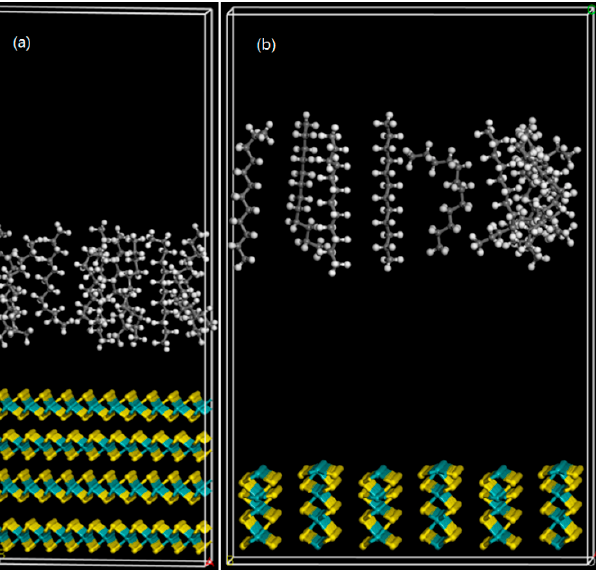
Figure 2. The optimization of the MS001/MS100–SCA compound model. ( a ) SCA and MS001; ( b ) SCA and